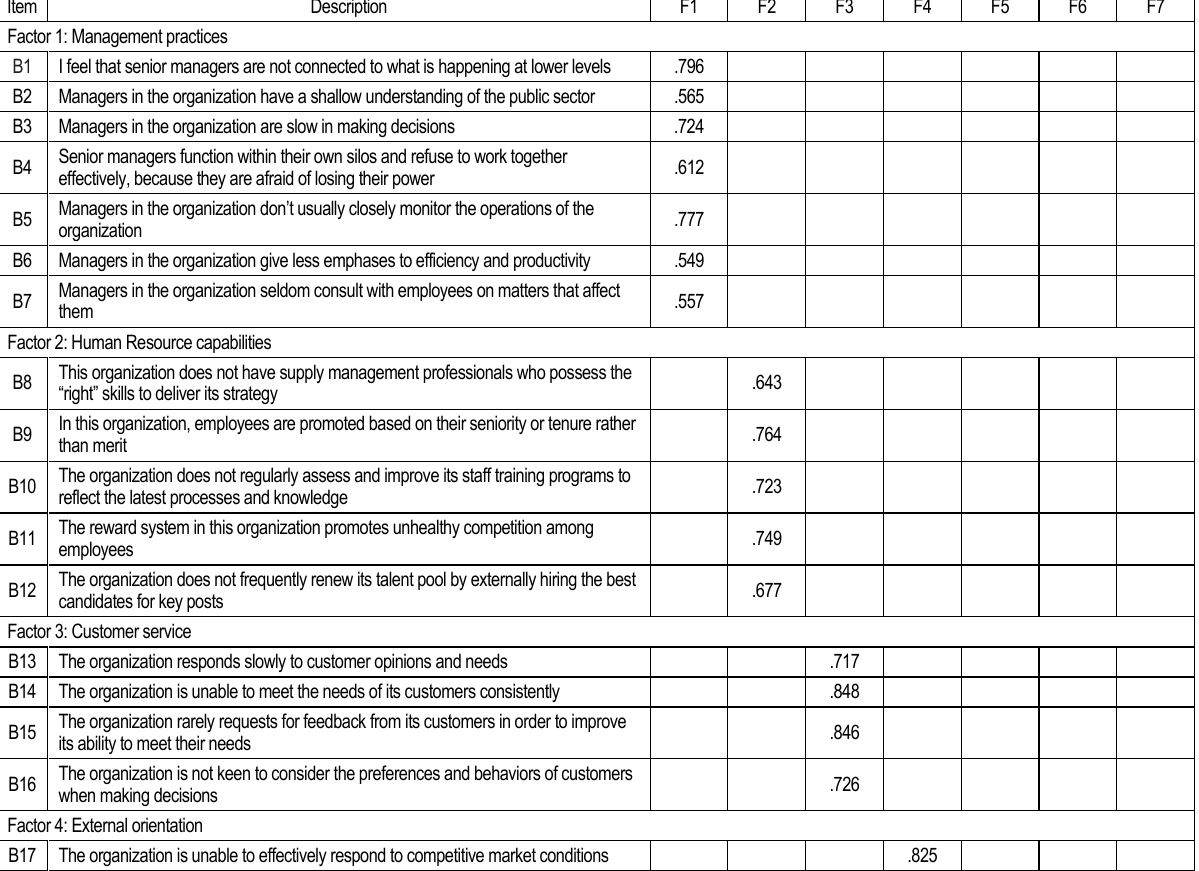
Table 1. Rotated component matrix: barriers to strategy